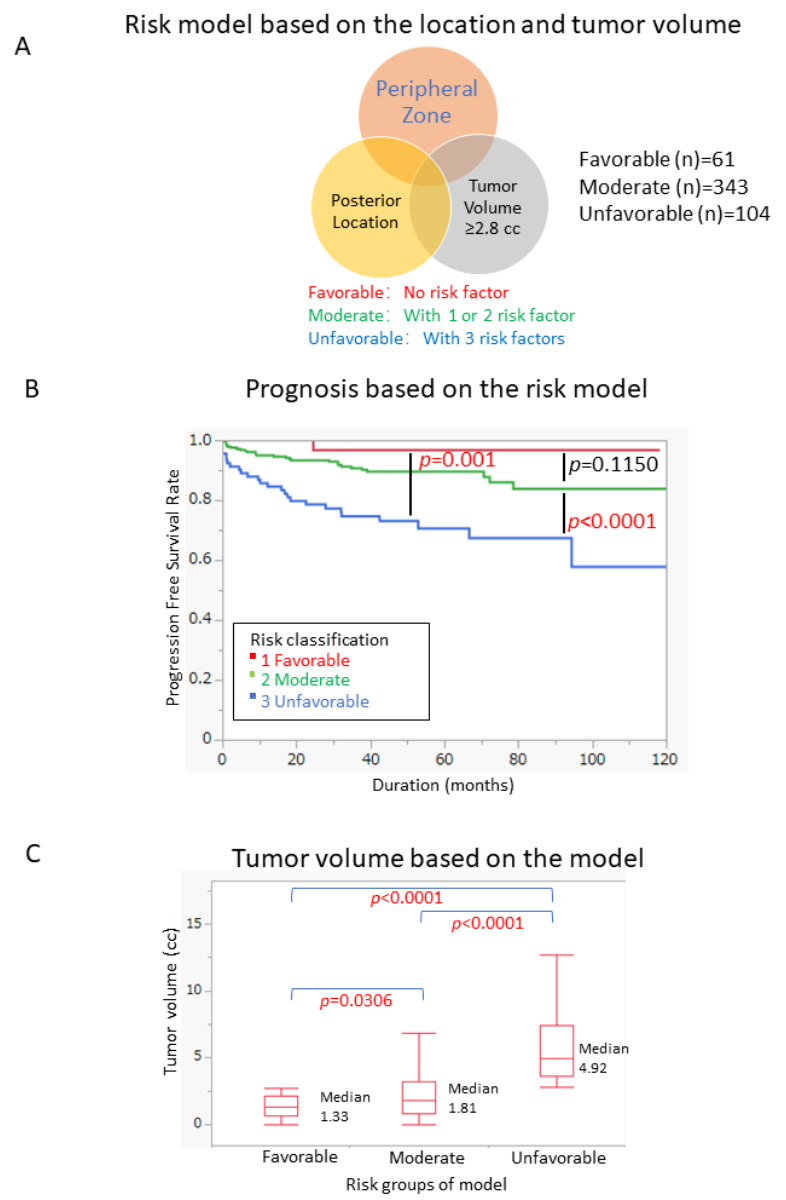
Figure 3. Prognostic model based on the location and tumor volume ( A ) Venn diagram of risk model based on the location and tumor volume. ( B ) Risk classification significantly differentiated the PFS between the Favorable and Unfavorable group ( p = 0.001) and the Moderate and Unfavorable group ( p < 0.0001). ( C ) The tumor volume showed significant differences among different risk groups.